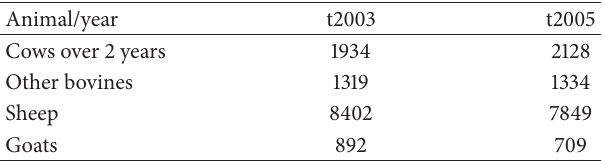
Table 6: Livestock numbers in Castelo de